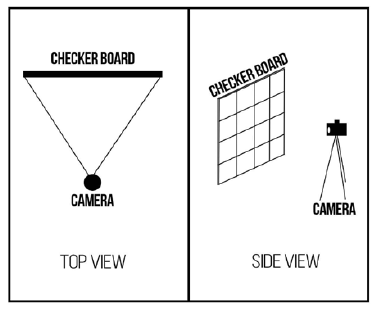
Figure 3. Illustration of the Camera Set-up